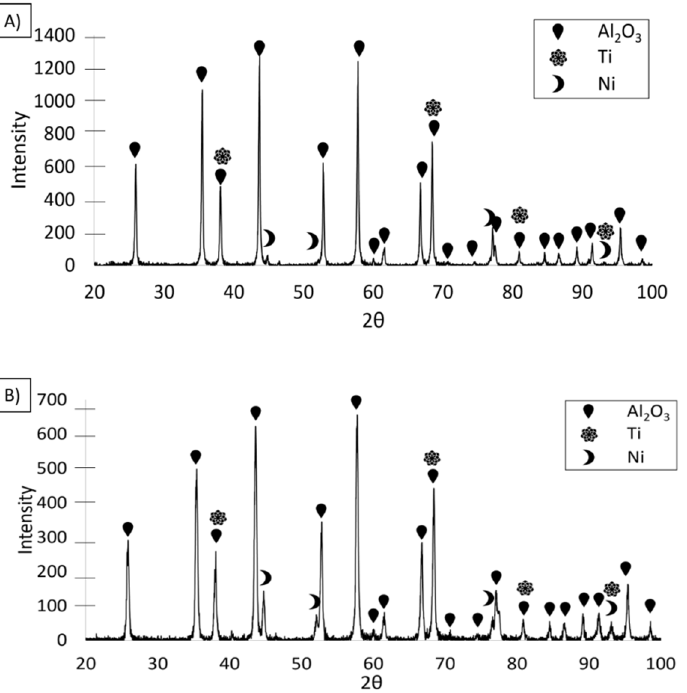
Figure 8. Diffractograms of the composites in the raw state with solid contents of ( A ) 35 vol%, and ( B ) 50 vol%.